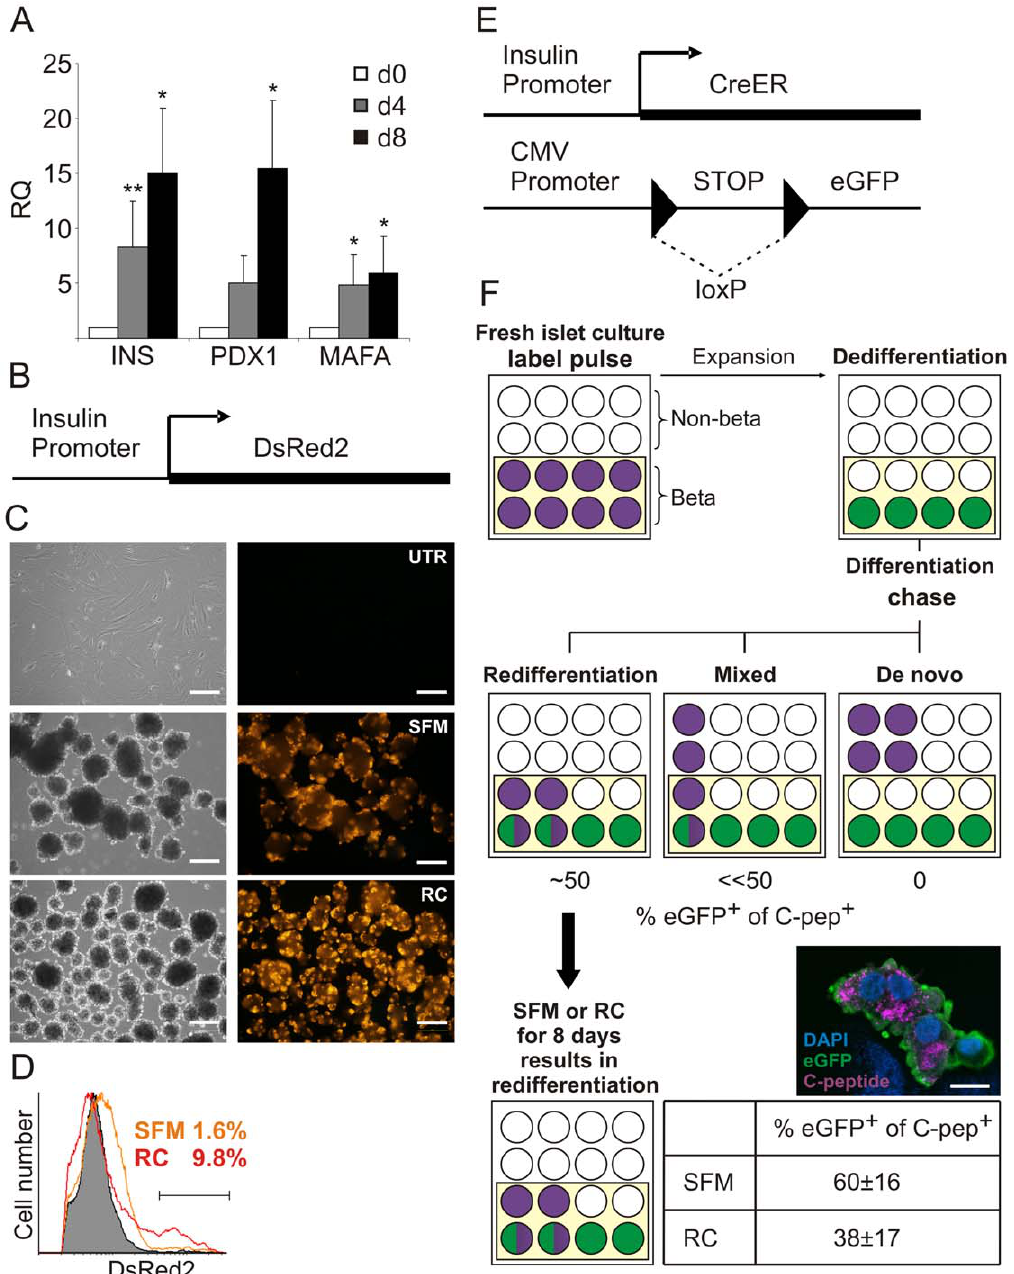
Figure 1. Development of conditions for islet cell differentiation, and demonstration that differentiation represents predominantly BCD-cell redifferentiation. A: qPCR analysis of beta-cell gene expression in expanded islet cells at p6 incubated in SFM for the indicated number of days. Values are mean 6 SD relative to untreated cells (d0) (n=3–4 donors) and normalized to human RPLPO. *p , 0.05; **p , 0.005. B–D: An assay for screening islet cell differentiation conditions. Islet cells are transduced with a RIP-DsRed2 lentivirus ( B ) followed by testing different differentiation conditions. C: No DsRed2 expression is observed in expanded cells at p5 (UTR, untreated cells), while cell transfer to SFM or RC results in insulin promoter activation, which can be monitored in live cells by appearance of DsRed2 fluorescence. Bar=200 m m. D: Flow cytometry quantitation of differentiation reveals that treatment with RC results in a 6-fold higher number of redifferentiated cells, compared with SFM. E: Schematic representation of the viral vectors used for beta-cell labeling. F: Predictions for generation of insulin-expressing cells by different cell sources within expanded islet cell populations. Initial cultures of islet cells consist of approximately half insulin-producing beta cells (purple filled circles) and half non-beta cells (open circles). The labeling efficiency of beta cells is about 50% (green filled circles). Dedifferentiated islet cells are expanded and then differentiated in SFM or RC, and the percent eGFP + cells among C-pep + cells is quantified. Redifferentiation of BCD cells is expected to result in , 50% co-staining, given the eGFP labeling efficiency. De novo differentiation of insulin-expressing cells from non-BCD cells should result in no co-staining, while occurrence of both mechanisms will result in a low percent of co-stained cells. The actual co-staining quantitation (bold arrow) revealed that redifferentiation of BCD cells was the predominant source of insulin-expressing cells generated in both conditions. Percentages indicate fraction of eGFP + cells among C-pep + cells redifferentiated from expanded islet cells at p4–6 (based on counting . 400 cells in each of 3 donors). A representative micrograph is shown. DNA was stained blue with DAPI. Bar=10 m m.